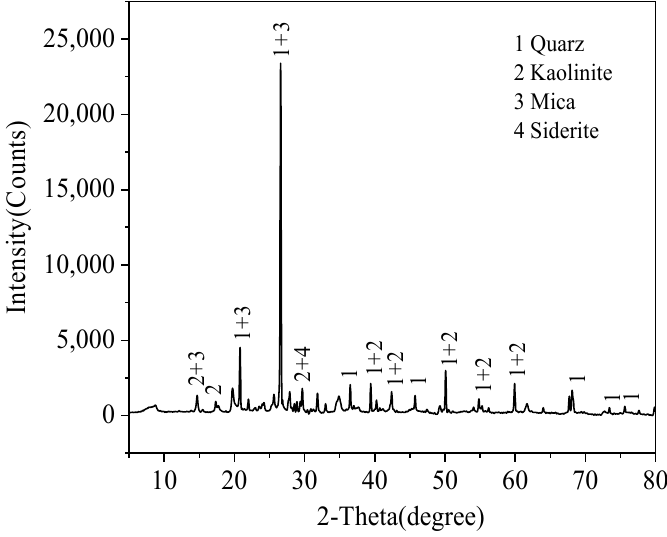
Figure 1. XRD pattern of coal gangue